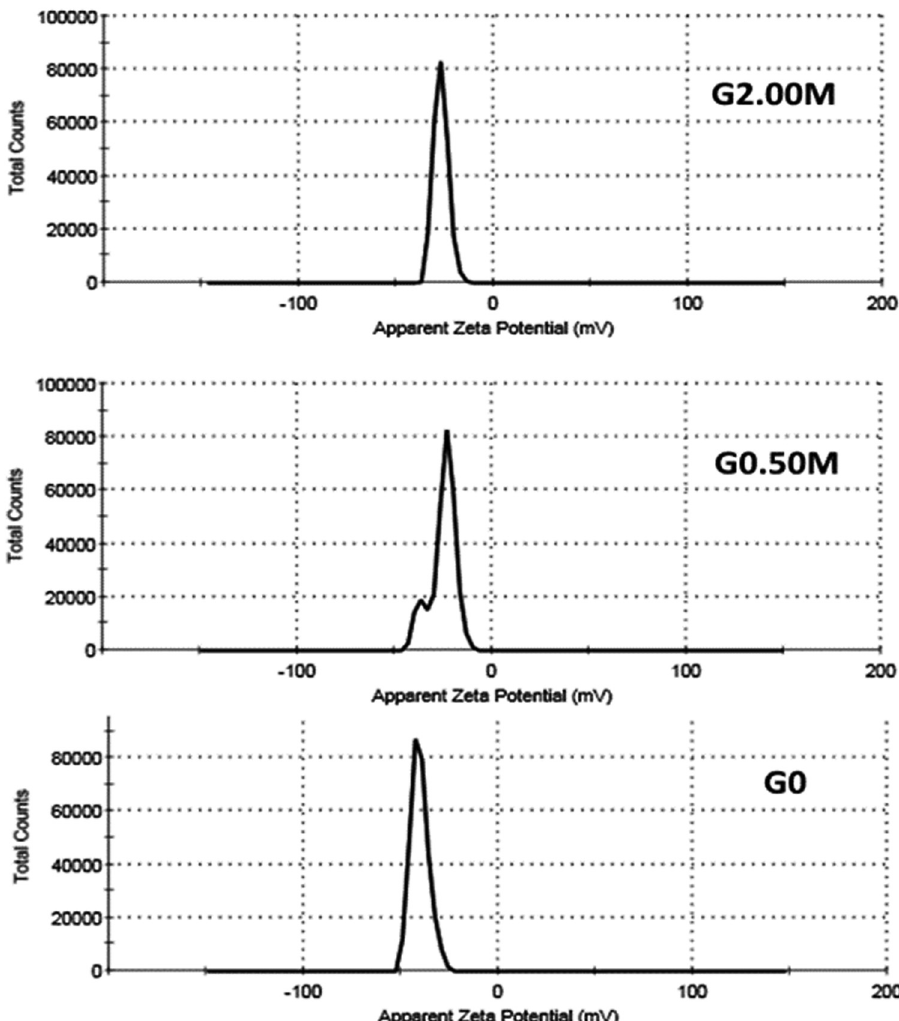
Figure 7: Zeta potential of G0, G0.50M and G2.00M glass samples sintered at 1,100°C/2